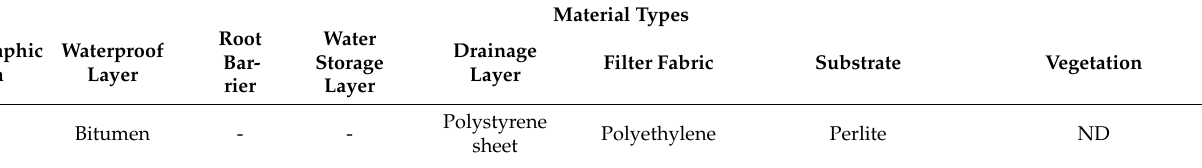
Table 7. Waste treatments assigned to each layer of the considered green roofs in the four analyzed LCA and LCC studies (ND = not declared in the article; - = not present in the considered green roof options).